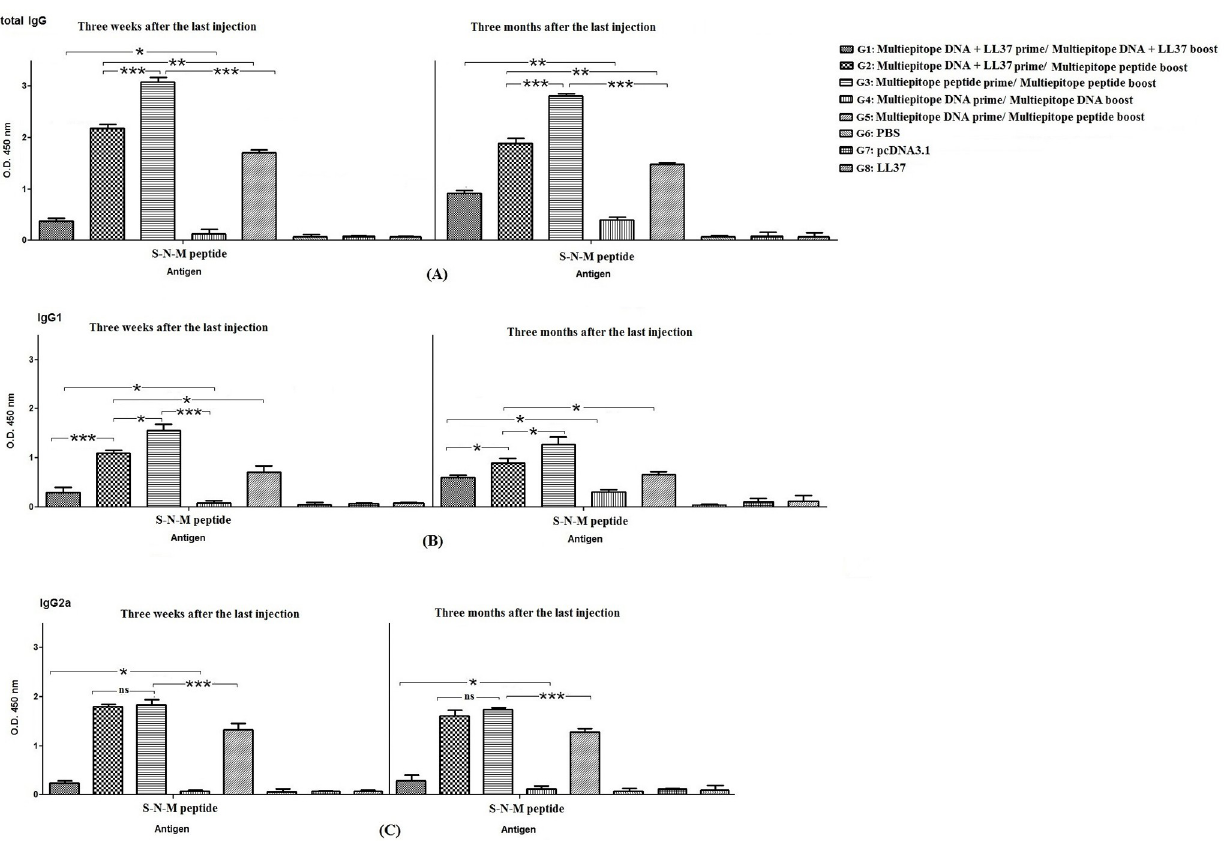
Fig 7. The levels of total IgG (A), IgG1 (B), and IgG2a (C) antibodies against S-N-M antigen at 3 weeks and 3 months after the last injection: Data were presented as the mean absorbance at 450 nm ± SD from two independent experiments. Significant differences were shown by � p < 0.05, �� p < 0.01, ��� p < 0.001, and non-significant difference was shown by ns ( p >